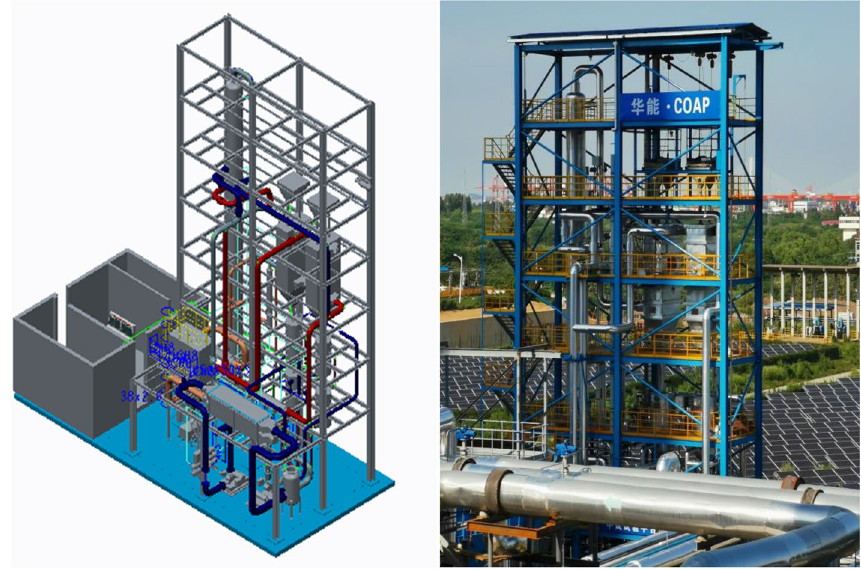
Figure 13. 3D model (left) and a photo (right) of the pilot test platform.